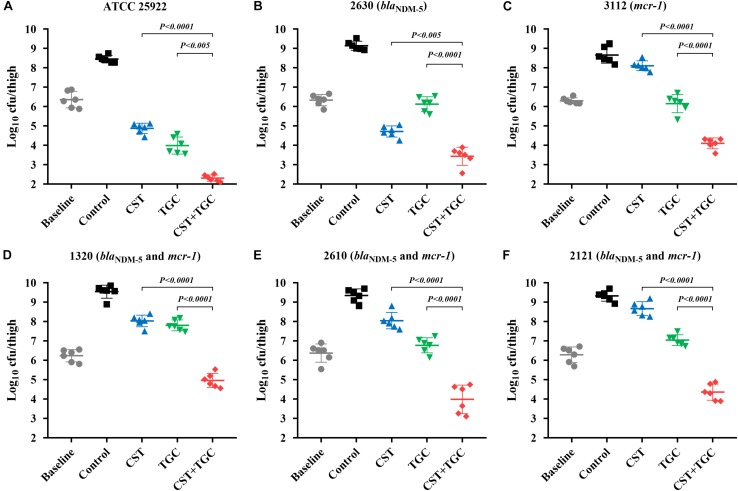
Efficacy of colistin and tigecycline mono- and combination therapies at 24 h against E. coli ATCC 25922 (A), 2630 (B), 3112 (C) and strains harboring blaNDM–5 and mcr-1
(D–F) in the murine thigh infection model with a low initial burden of 106 cfu/thigh. Colistin (7.5 mg/kg i.p. bid) and tigecycline (5 mg/kg s.c. bid) and the combination were administrated at 2 h post-infection. Horizontal lines represent the mean and standard deviation of bacterial densities for each group (n = 6). Colistin and tigecycline combination therapy resulted in a >2.0 log10cfu/thigh reduction relative to each monotherapy (P < 0.0001, Mann-Whitney U-test).